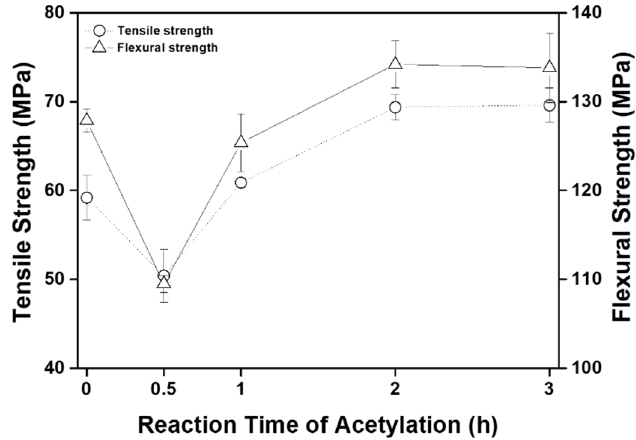
Figure 1. Tensile and flexural strength of composites as a function of acetylation reaction time.